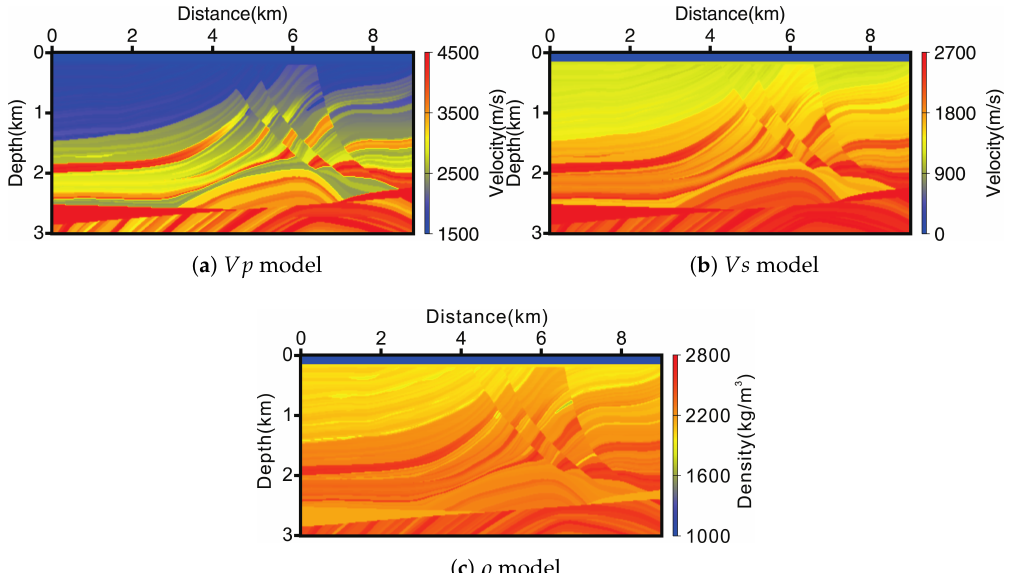
Figure 1. True parameters of the elastic Marmousi model: Vp ( a ), Vs ( b ), and ρ ( c ).